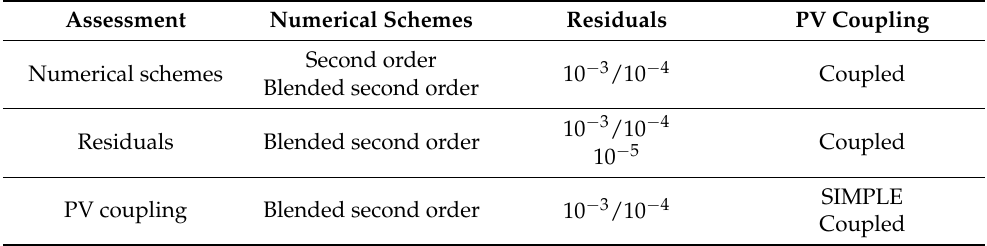
Table 4. Evaluation matrix for different considered parameters in the numerical